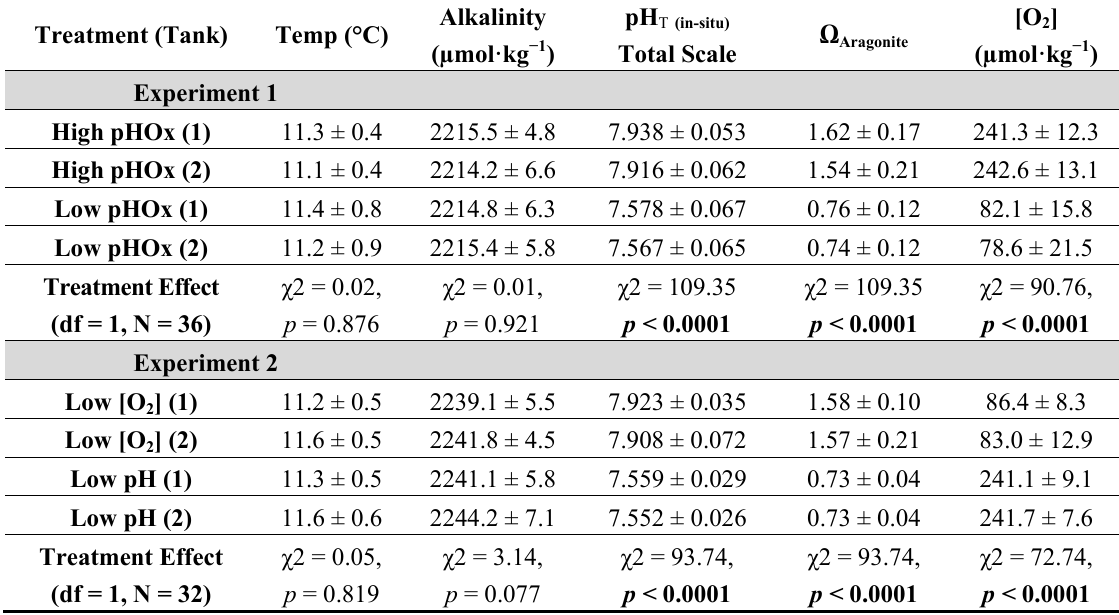
Table 1. Average ±1 standard deviation for temperature (°C), alkalinity (µmol·kg − 1 ), pH ] (µmol·kg − 1 ) in tanks during Experiment 1 and Experiment 2. Treatments were and [O 2 distinct for pH , Ω and [O ], but not temperature and alkalinity (Wilcoxon T aragonite 2